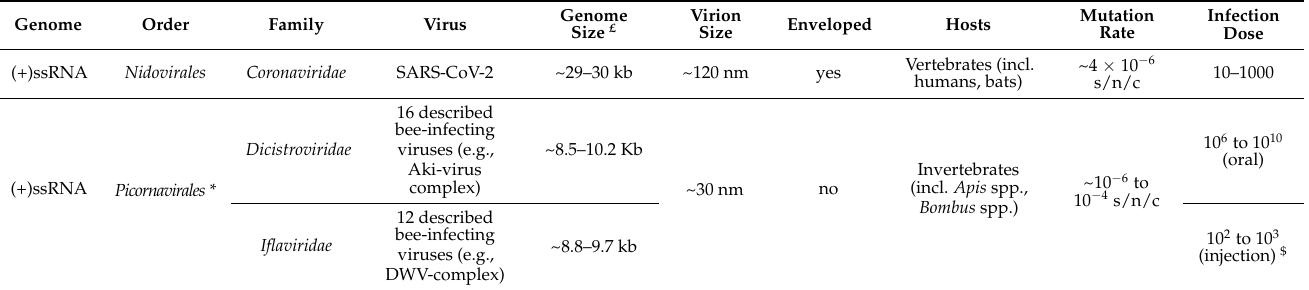
Table 1. Comparison between SARS-CoV-2 and two common bee virus